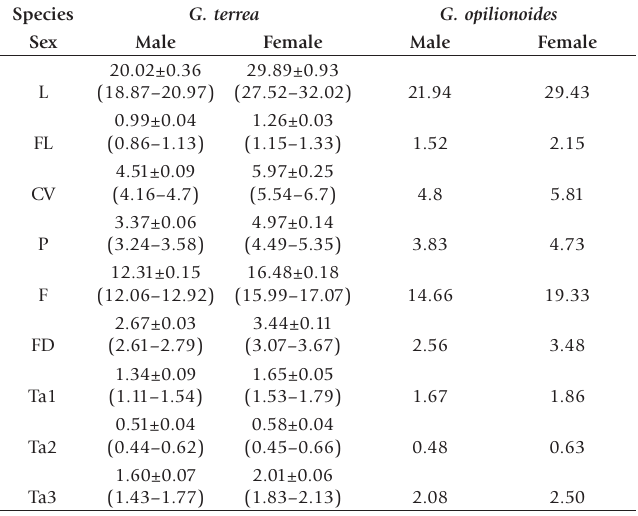
Table 1. Measurements (mm) of G. terrea and G. opilionoides. The values in the table represent: mean ± standard error (min–max). All measurements for G. terrea repeated for five specimens, except tarsal measurements which were repeated for four